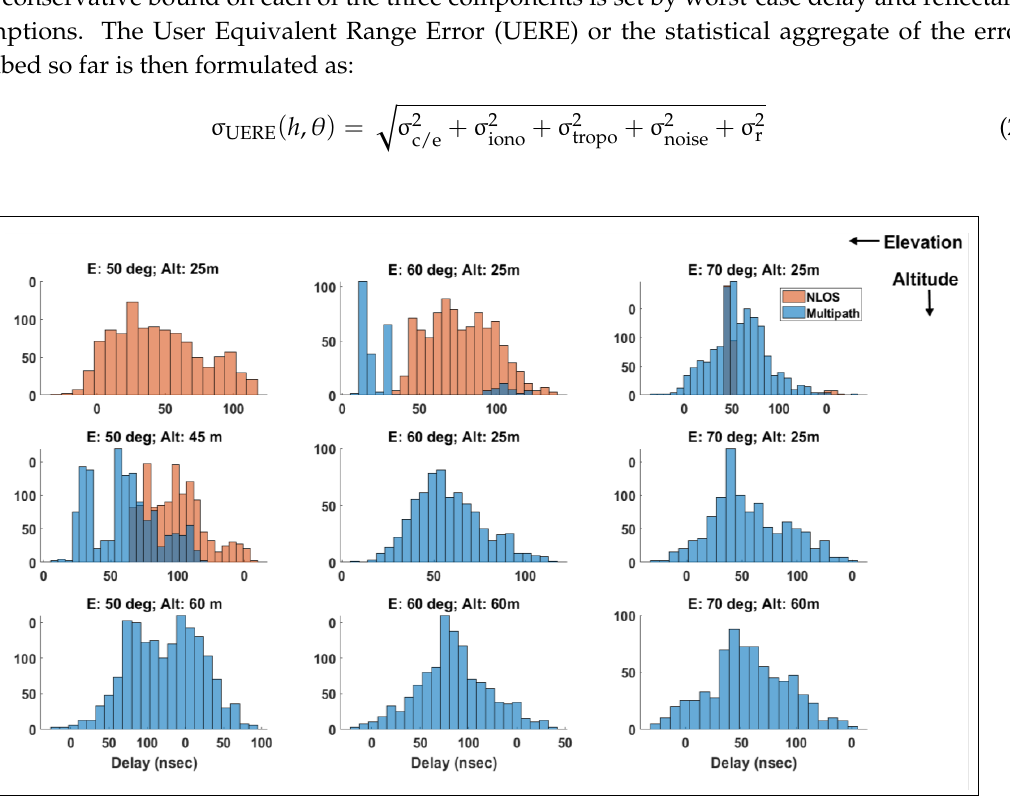
Figure 10. Histogram of NLOS and multipath delays for varying satellite elevations and altitude AGL in an urban canyon.